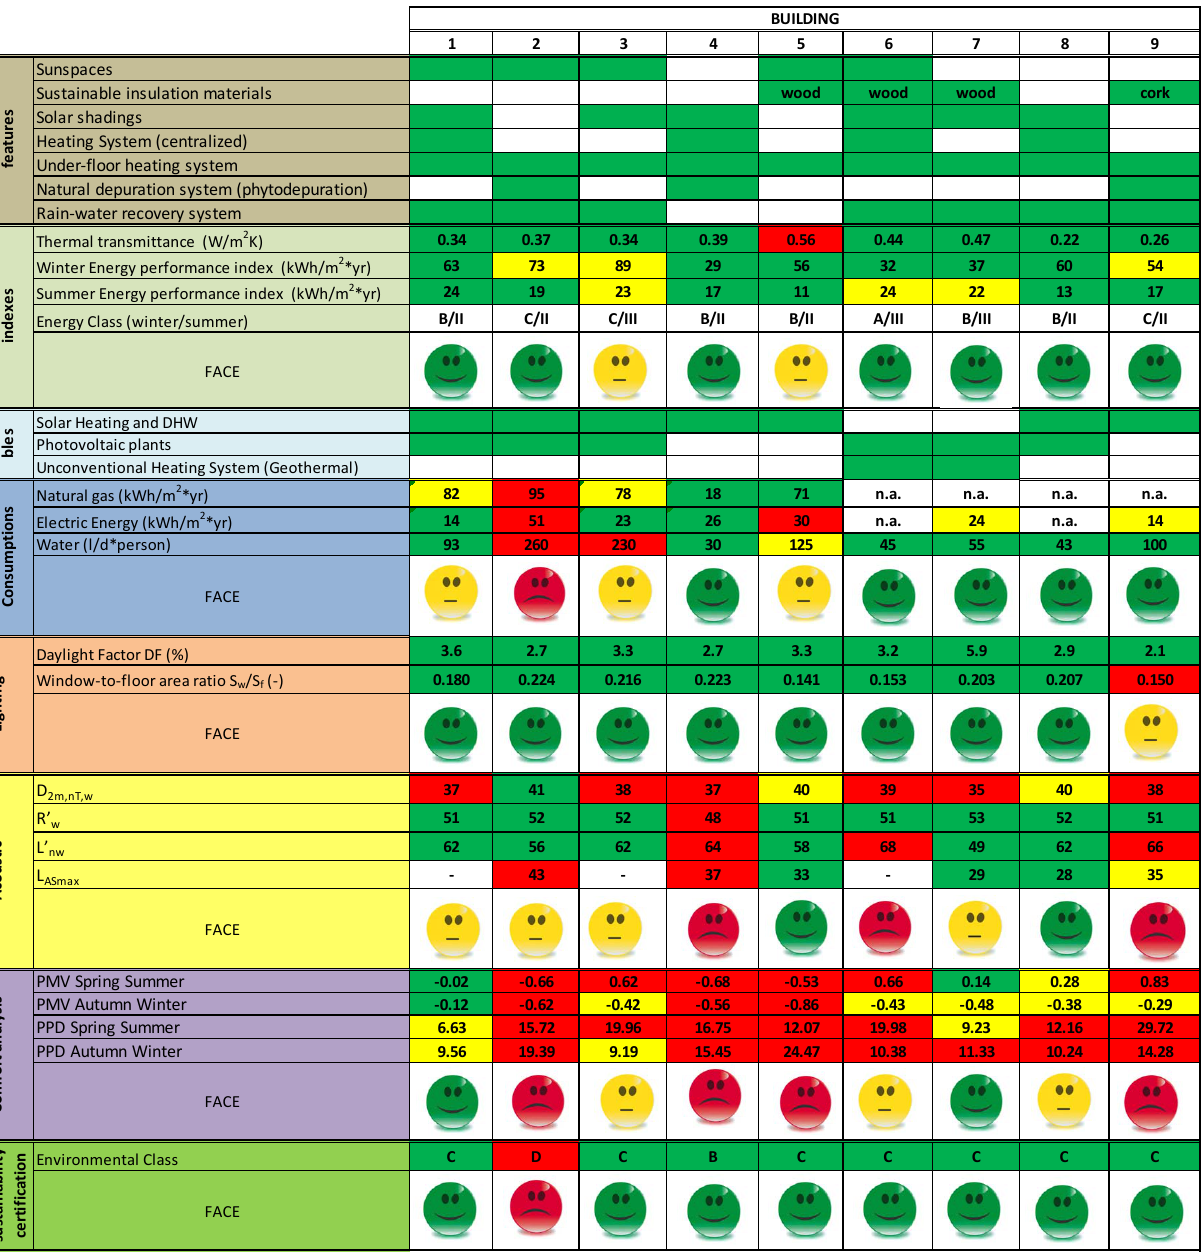
Figure 13. Results of the monitoring process for the nine analyzed buildings (Chercoff icons). Green = Satisfactory; Yellow = Average; Red =